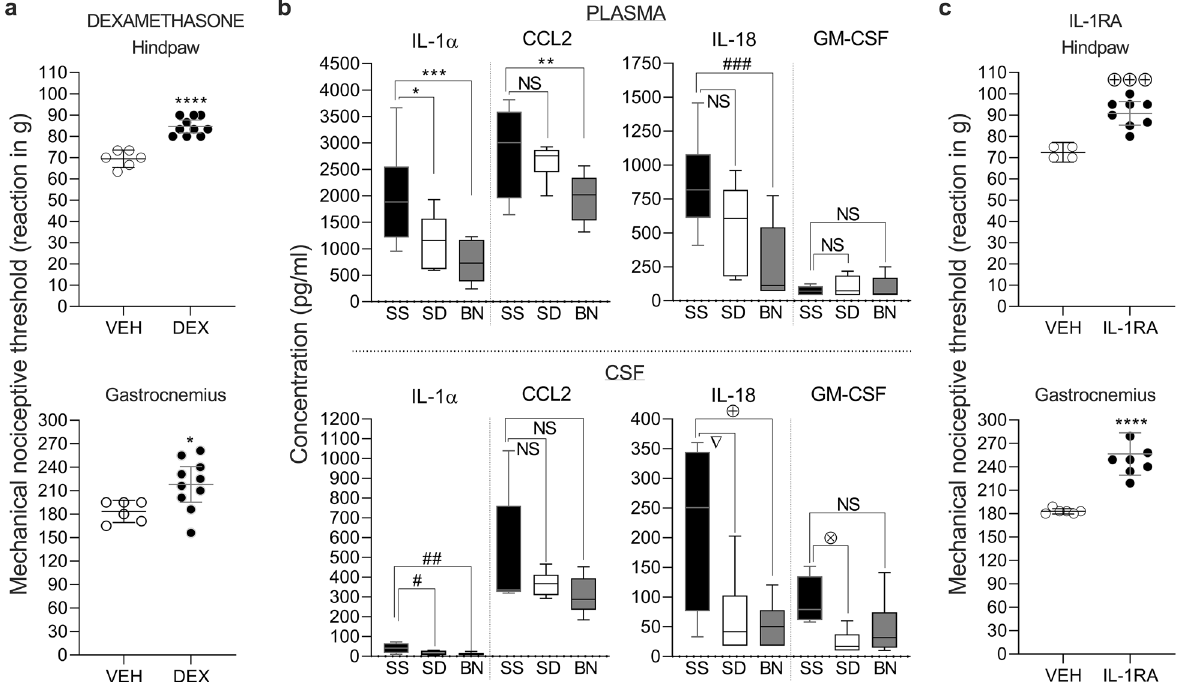
Figure 2. Inflammation contributes to the SS hyperalgesic phenotype. ( a ): SS rats were treated with vehicle (empty symbols) or the glucocorticoid dexamethasone (DEX, 1 mg/kg, s.c., full symbols). Evaluation of the nociceptive thresholds on the dorsum of the hindpaw (upper panel) or the gastrocnemius muscle (lower panel) 24 h later showed a significantly increased threshold in the DEX-treated group (t 14 = 7.179, **** p < 0.0001 for the hindpaw, compared with the vehicle-treated group, unpaired Student’s t-test; t 14 = 2.500, * p = 0.0254 for the muscle); ( b ): Multibead immunoassay evaluation of cytokine and chemokine levels in plasma and CSF samples collected from SS (black bars), SD (blank bars) and BN (gray bars) rats. Higher levels of IL-1α were found in the plasma of SS (upper panels, F (2,22) = 9.453, p = 0.0011, one-way ANOVA followed by Bonferroni posttest) compared to SD (* p = 0.0439) and BN (*** p = 0.0006), as well as in the CSF (lower panels, F (2,13) = 5.492, p = 0.0187, with # p = 0.0443 for SD and ## p = 0.0138 for BN rats). IL-18 levels were elevated in the SS plasma (F (2,23) = 9.238, p = 0.0011), higher than in BN ( ### p = 0.0005), but not different from SD ( p = 0.1308, NS). In the SS CSF, IL-18 was higher (F (2,13) = 5.722, p = 0.0165) than in SD ( ∇ p = 0.0244) and BN ( ⊕ p = 0.0161). No difference in GM-CSF concentration was found in the SS plasma (F (2,22) = 0.3469, p = 0.7107) compared to SD ( p = 0.8614, NS) and BN ( p > 0.9999, NS) or in the CSF of BN ( p = 0.1821, NS). However, GM-CSF was higher in SS rat CSF (F (2,13) = 3.859, p = 0.0483) than in SD rat CSF ( ⊗ p = 0.0318). Similarly, the CCL2 concentration in SS plasma was higher (F (2,23) = 6.222, p = 0.0069) only when compared to BN (** p = 0.0048) but not to those in plasma ( p > 0.9999, NS) or CSF ( p = 0.4562, NS) of SD and BN ( p > 0.1793, NS). ( c ): SS rats received an i.p. injection of IL-1RA (10 mg/kg, full symbols) or vehicle (empty symbols). An increase in nociceptive thresholds in the IL-1RA-treated group was observed 60 min later on the hindpaw (upper panel, t 10 = 5.200, ⊕⊕⊕ p = 0.0004, compared to the vehicle group, unpaired Student’s t-test) and in the muscle (lower panel, t 12 = 5.475, **** p < 0.0001). ( a ): vehicle, n = 6, DEX, n = 10; ( b ), plasma: SS, n = 10; SD, n = 6; BN, n = 10; Panel b, CSF: SS, n = 5; SD, n = 6; BN, n = 6; ( c ): vehicle, n = 6, IL-1RA, n =